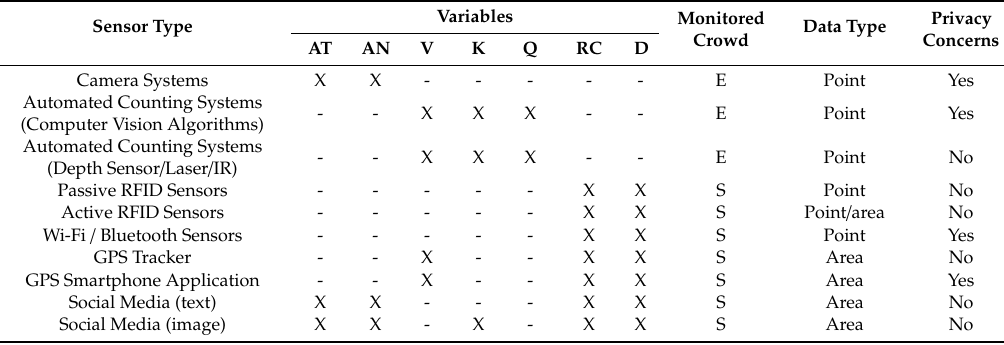
Table 1. Summary of insights that can be directly captured using a specific type of sensor without assumptions or information from other data